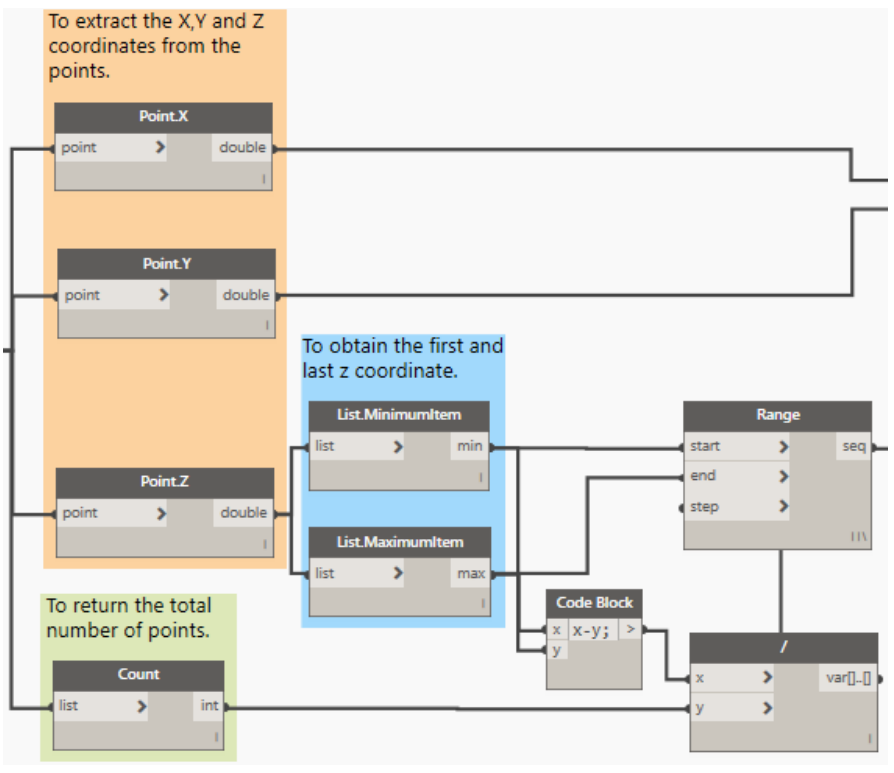
Figure A8. Creation of the printing trajectory.